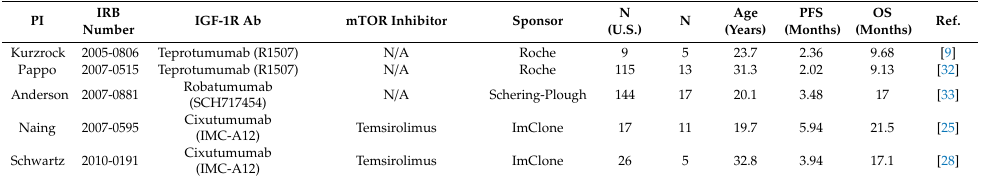
Table 1. Five IGF-1R-related clinical trials were used assessed to evaluate the clinical outcomes of ES patients treated at